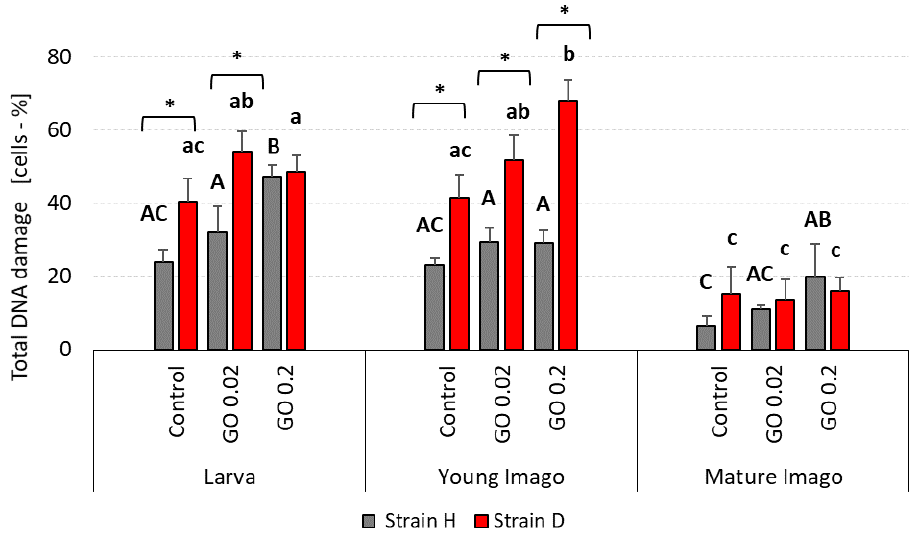
Figure 1. Total DNA damage in the gut cells of the wild (H) and long-living (D) strains of A. domesticus that had been chronically intoxicated with graphene oxide (GO). Abbreviations: Measurements were conducted at larva (n = 5), young imago (n = 5) and mature imago stage (n = 3). Control—animals fed uncontaminated food; GO 0.02 and GO 0.2 groups of animals fed GO contaminated food at a concentration of 0.02 or 0.2 mg∙kg –1 of dry food, respectively. Significant differences were measured using ANOVA (Fisher test; p < 0.05). Different letters denote differences among the experimental groups in the strain. Capital letters refer to strain H, while lowercase letters refer to strain D; asterisks indicate differences between the strains in each experimental group